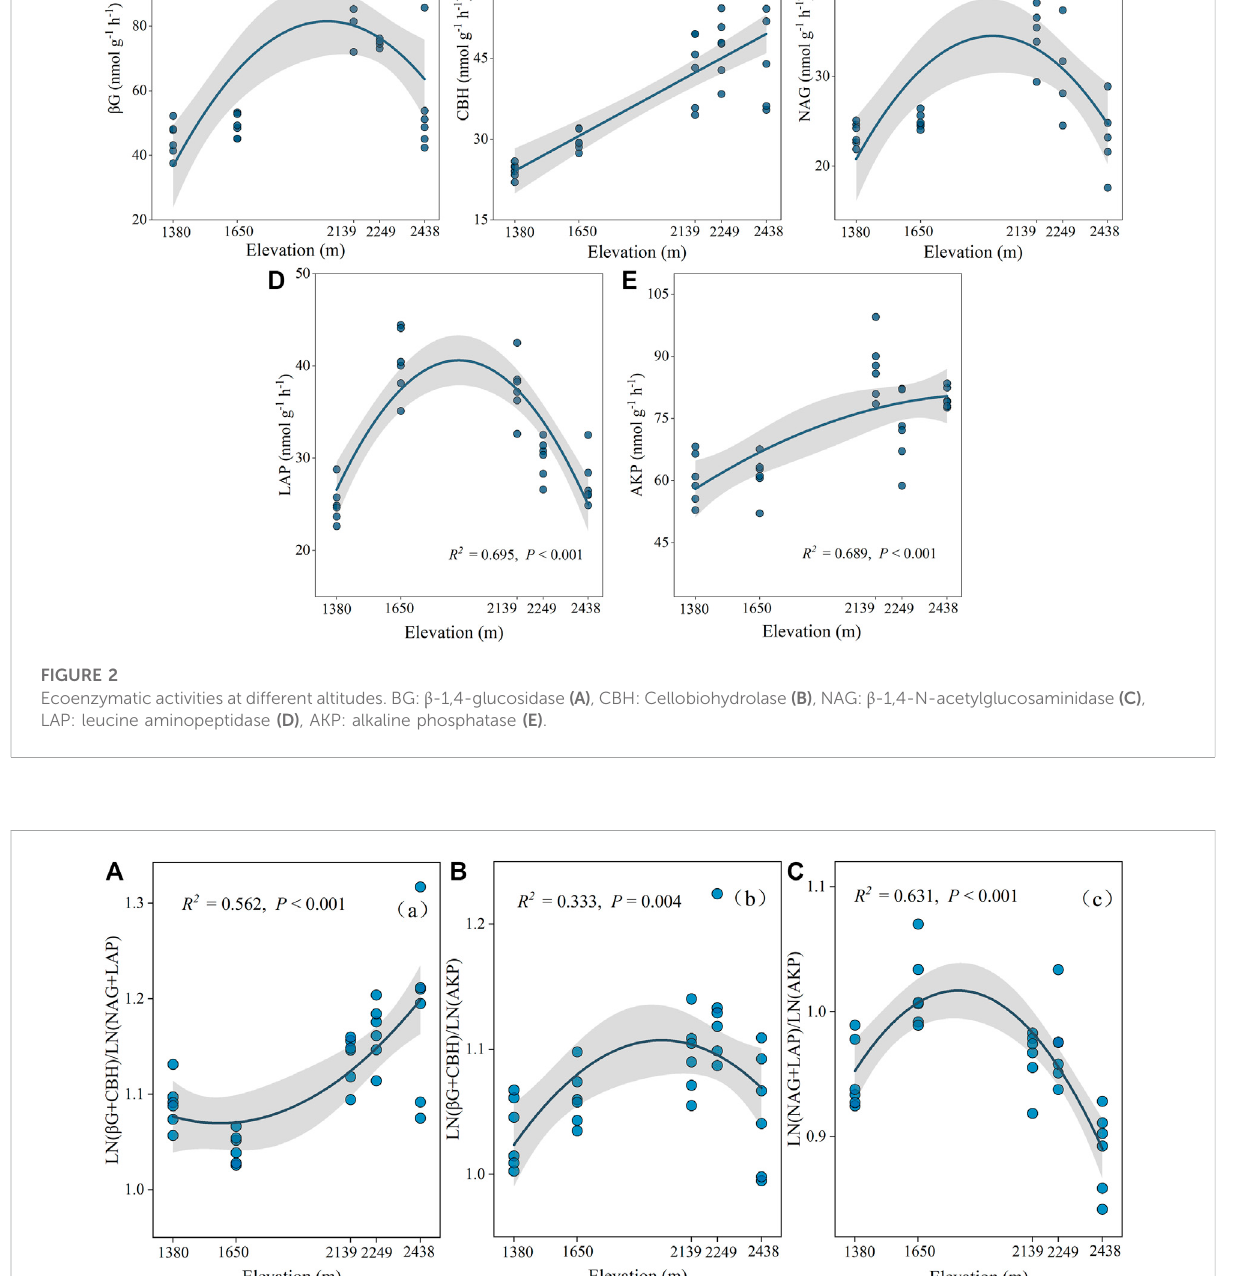
Frontiers in Environmental